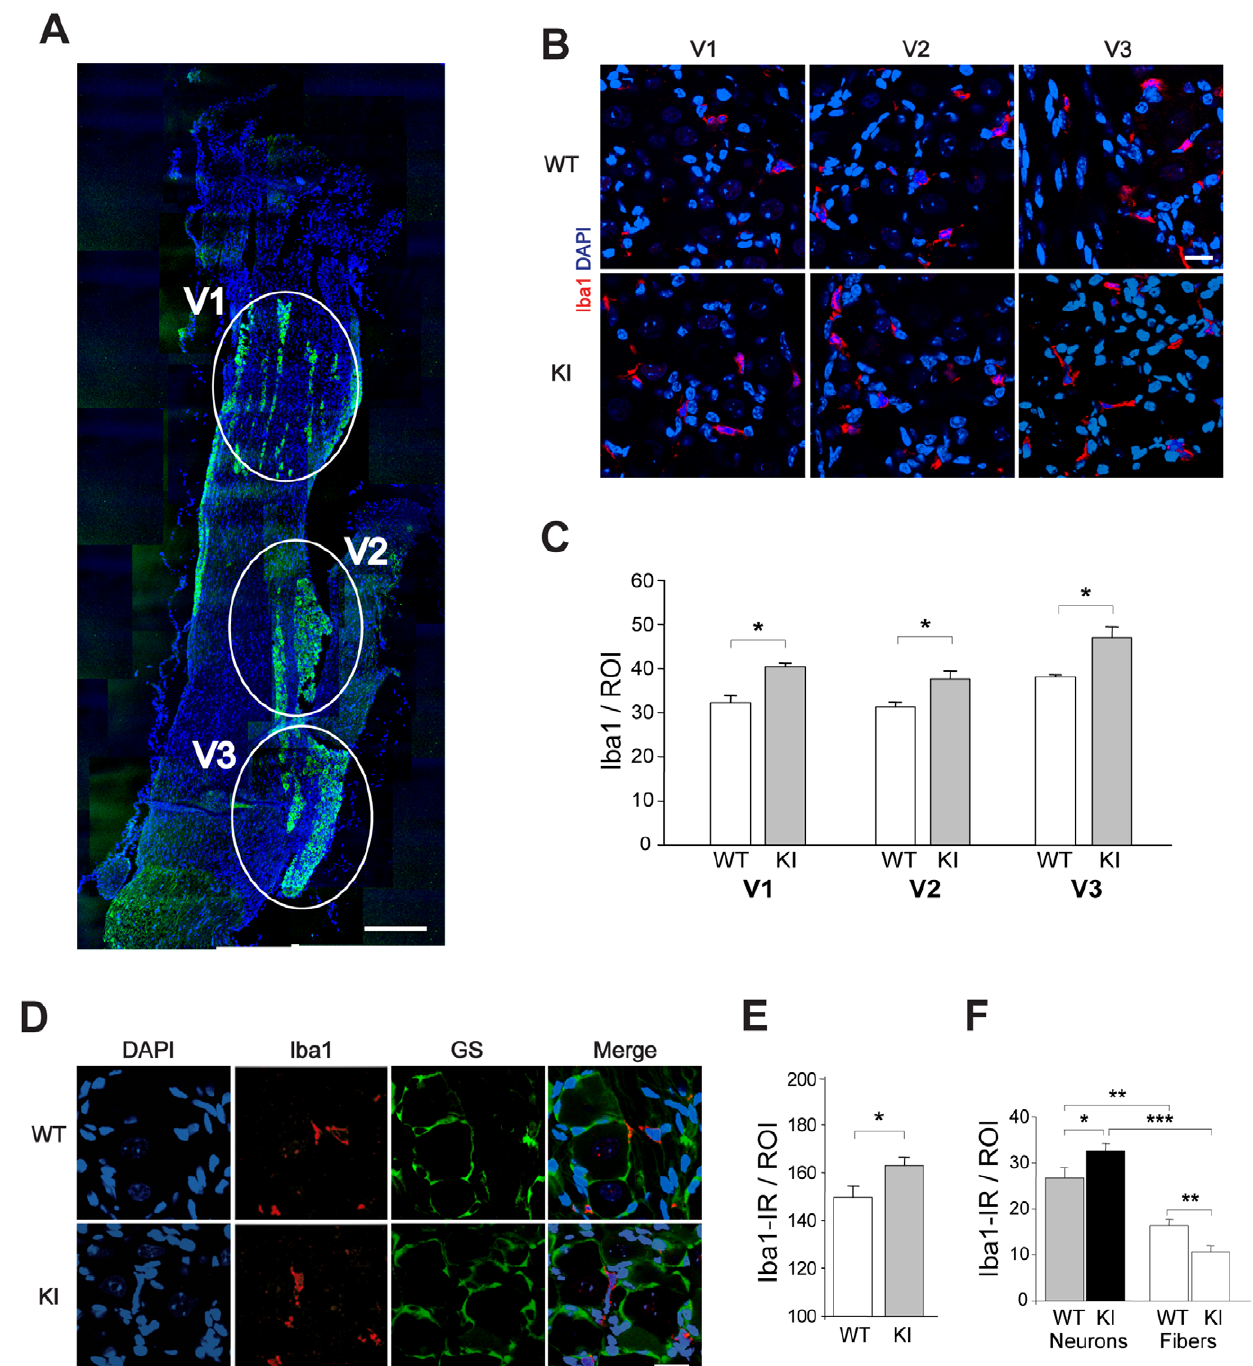
Figure 1. Iba1 immunoreactivity in trigeminal ganglia from in WT and R192Q KI mice. A , Representative confocal microscopy image of a longitudinal section of mouse trigeminal ganglion immunostained for neuronal b -tubulin III (green), and labeled with DAPI (blue). Discrete distribution of neuronal somata in three histological subdivisions of the trigeminal ganglion (i.e. V1, V2 and V3) is indicated by ellipsoids. Scale bar: 300 m m. B , Representative confocal microscopy images of WT (top row) or R192Q KI (bottom row) trigeminal ganglion sections from different V1, V2 and V3 regions of WT and KI ganglia and immunostained with Iba1 (red). Nuclear signal is also shown (blue). Scale bar: 15 m m. C , Histograms quantify Iba1-positive cells in V1, V2 and V3 regions (ROI: 370 m m 6 370 m m) of WT and KI trigeminal ganglia. Data were collected in parallel from at least 3 WT and 3 KI mice; * p , 0.01. D , Panels show confocal images of WT (top row) and R192Q KI (bottom row) trigeminal ganglion sections immunostained with anti-Iba1 (red, macrophages) and the anti-glutamine synthetase antibodies (GS, green, satellite glial cells). Nuclei were labeled with DAPI (blue). Note the peculiar GS-positive immunostaining of satellite glial cells typically surrounding neurons (green). No Iba1 co-localisation was found in GS- immunolabeled cells. Scale bar: 20 m m. E , Histograms quantify the Iba1-immunoreactivity (IR) in whole ganglion slices from R192Q KI with respect to WT samples. Data are from an average of 30 ROIs per whole ganglion, respectively from n =6 WT and KI mice. ROI: 640 6 480 m m. n=6 mice, * p , 0.001. F , Iba1 immunoreactivity was counted in neuronal- ( b -tubulin III-positive) or fiber- (MAP-2-positive, not shown) enriched ganglia regions; n =3 mice; * p , 0.05; ** p , 0.01; *** p , 0.001.